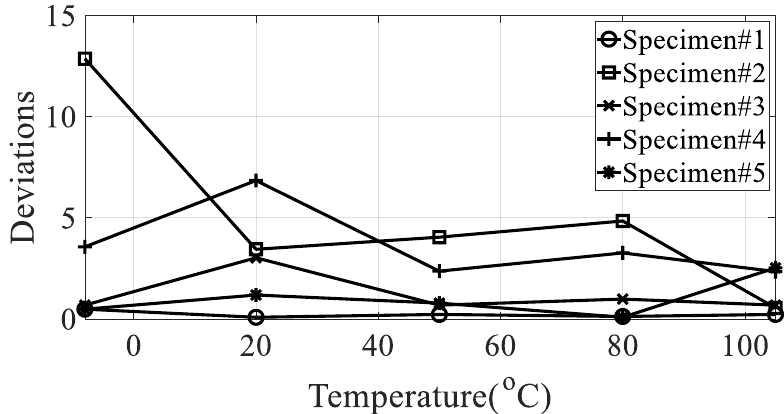
Figure 11. Deviation of the modal damping coefficient from the mean value according to different temperature conditions.